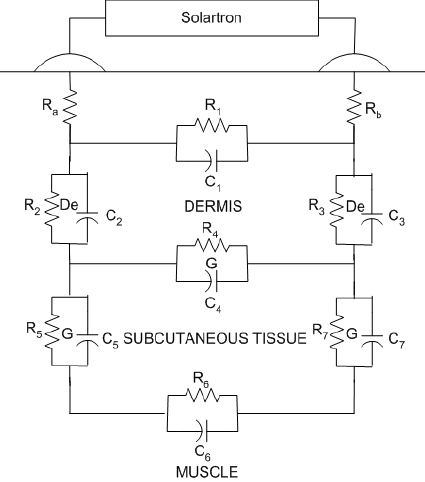
Fig. 1: Equivalent electrical circuit to the biological